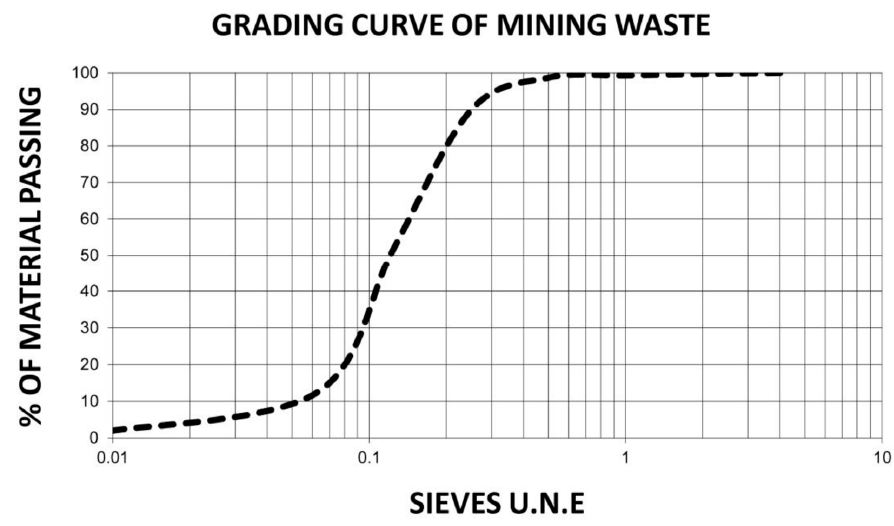
Figure 1. Grading curve of mining waste coming from tailings from washing plants.